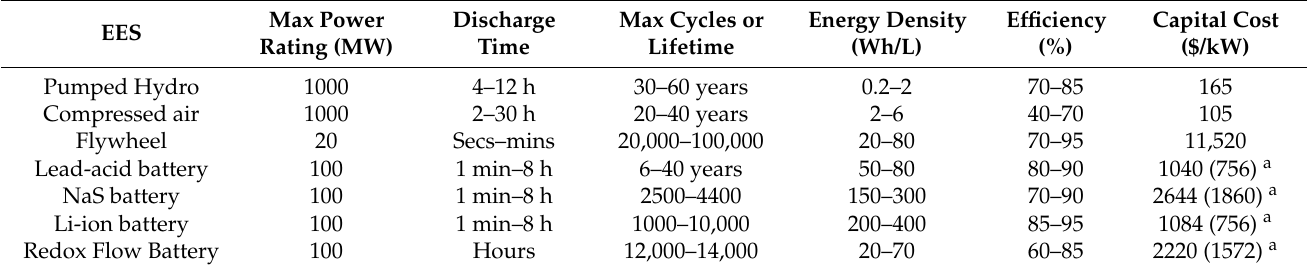
Table 1. Main characteristics of various Energy Storage Systems.